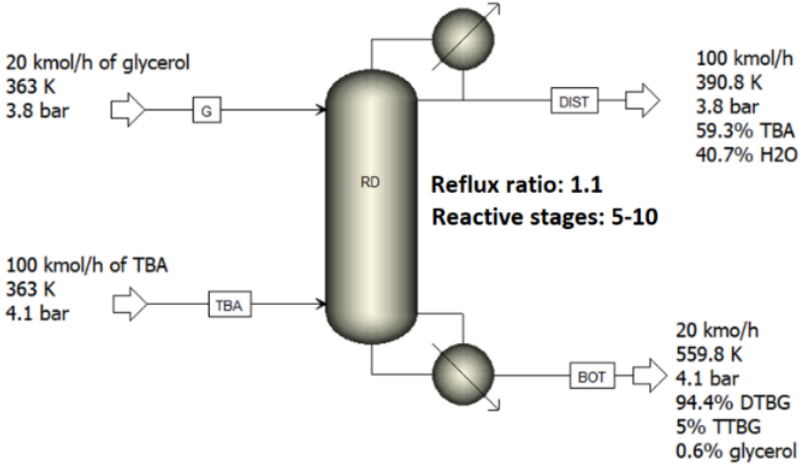
Figure 7. Reactive distillation column for glycerol etherification with TBA (reflux ratio = 1.1, Reactive stages = 6, TBA:Gly = 5).